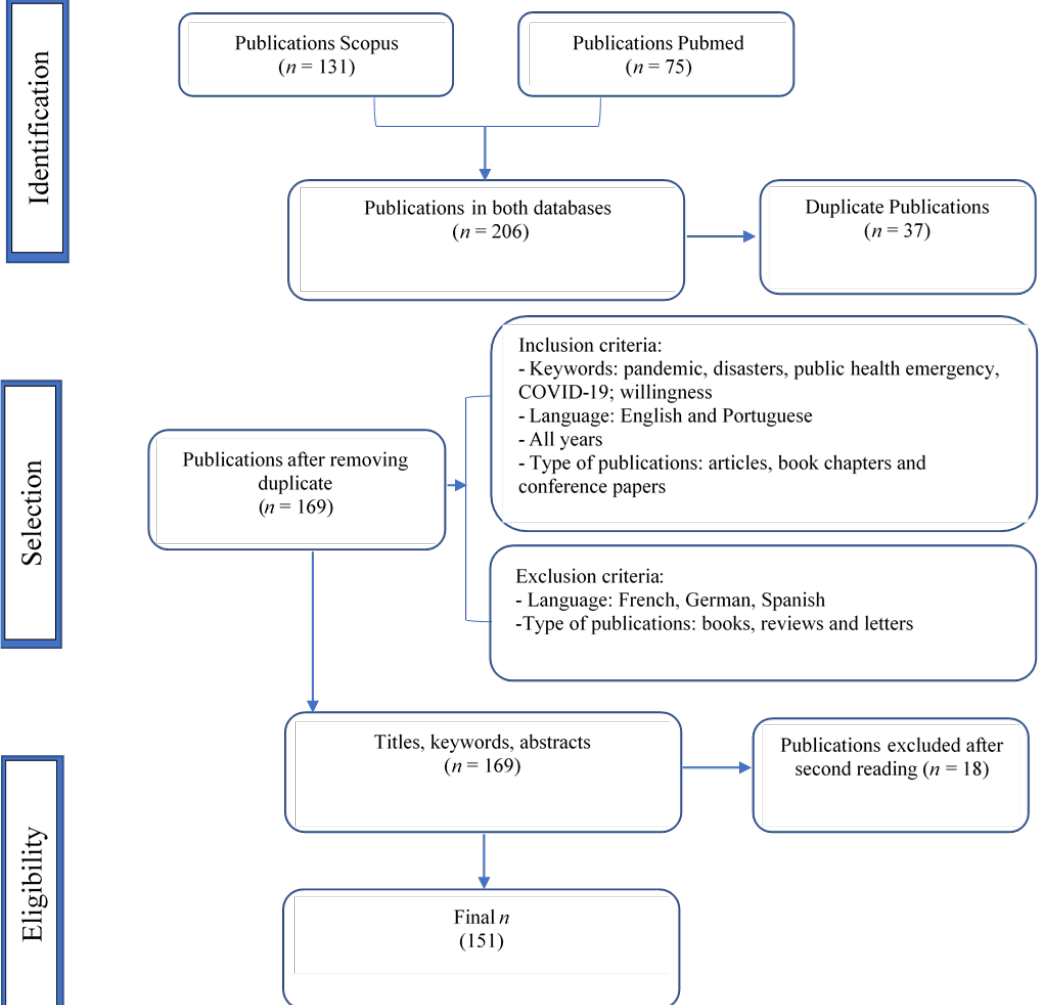
Figure 1. PRISMA flowchart.